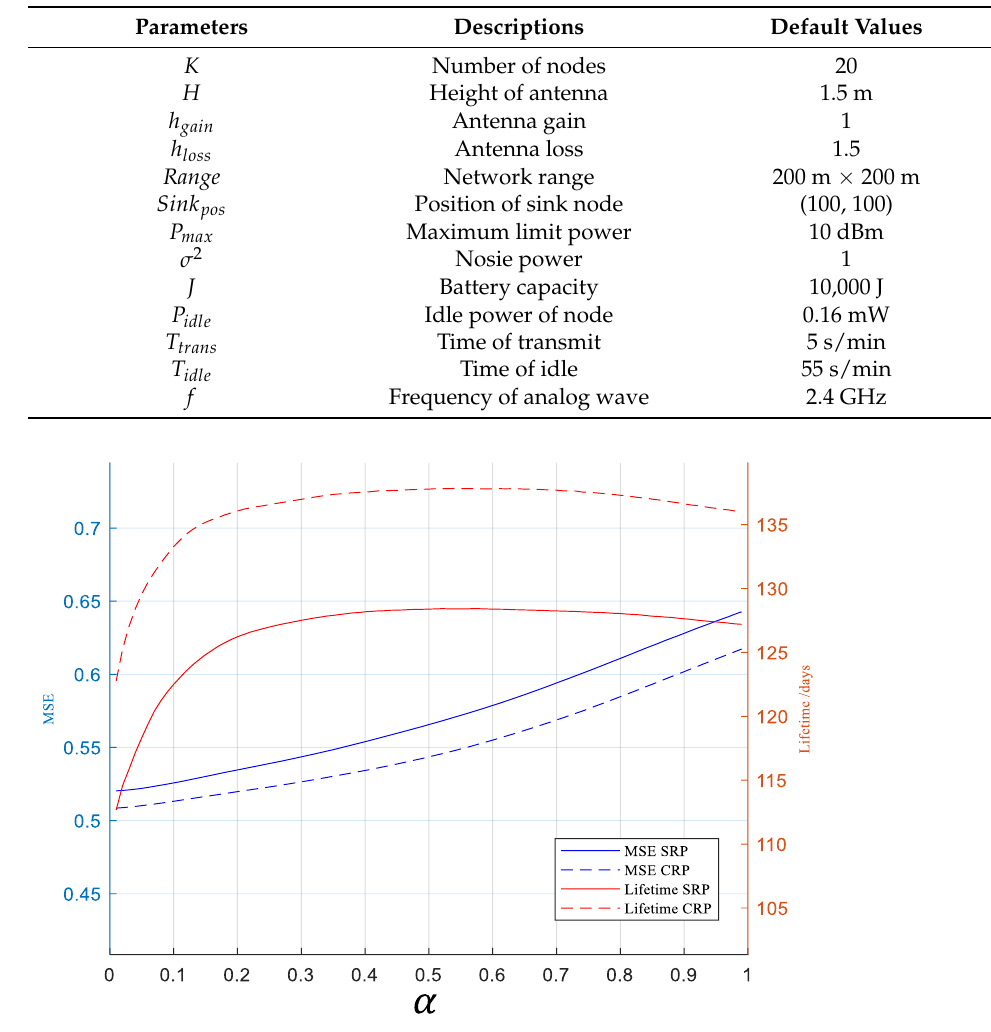
Table 1. Main notations and their default values.